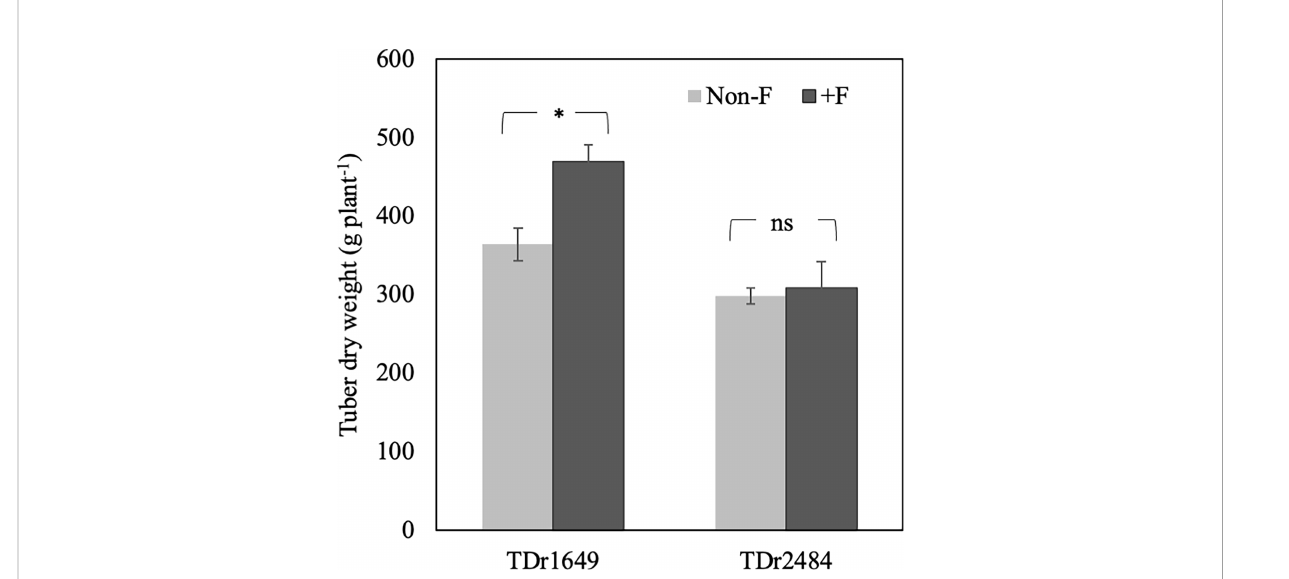
FIGURE 2 Effect of fertilizer treatment on dry tuber weight (g plant -1 ) in two white Guinea yam ( Dioscorea rotundata ) genotypes in 2017. * represents a signi fi cant difference at p < 0.05 calculated by t-test between non-fertilized (non-F) and fertilized (+F) conditions. ns;